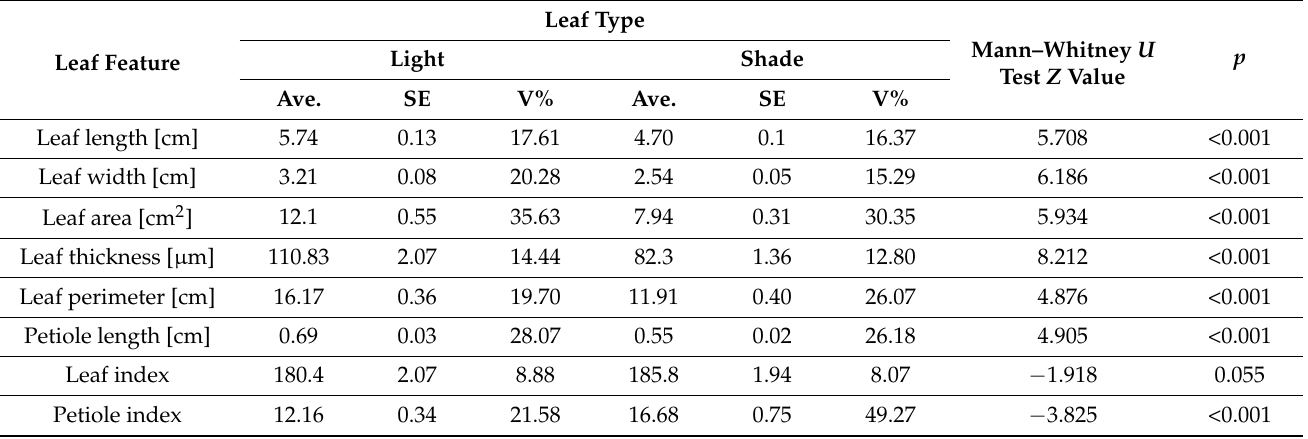
Table 2. Effect of leaf type (sun or shade leaves) on their morphological characteristics (mean ± standard error) (Mann–Whitney U